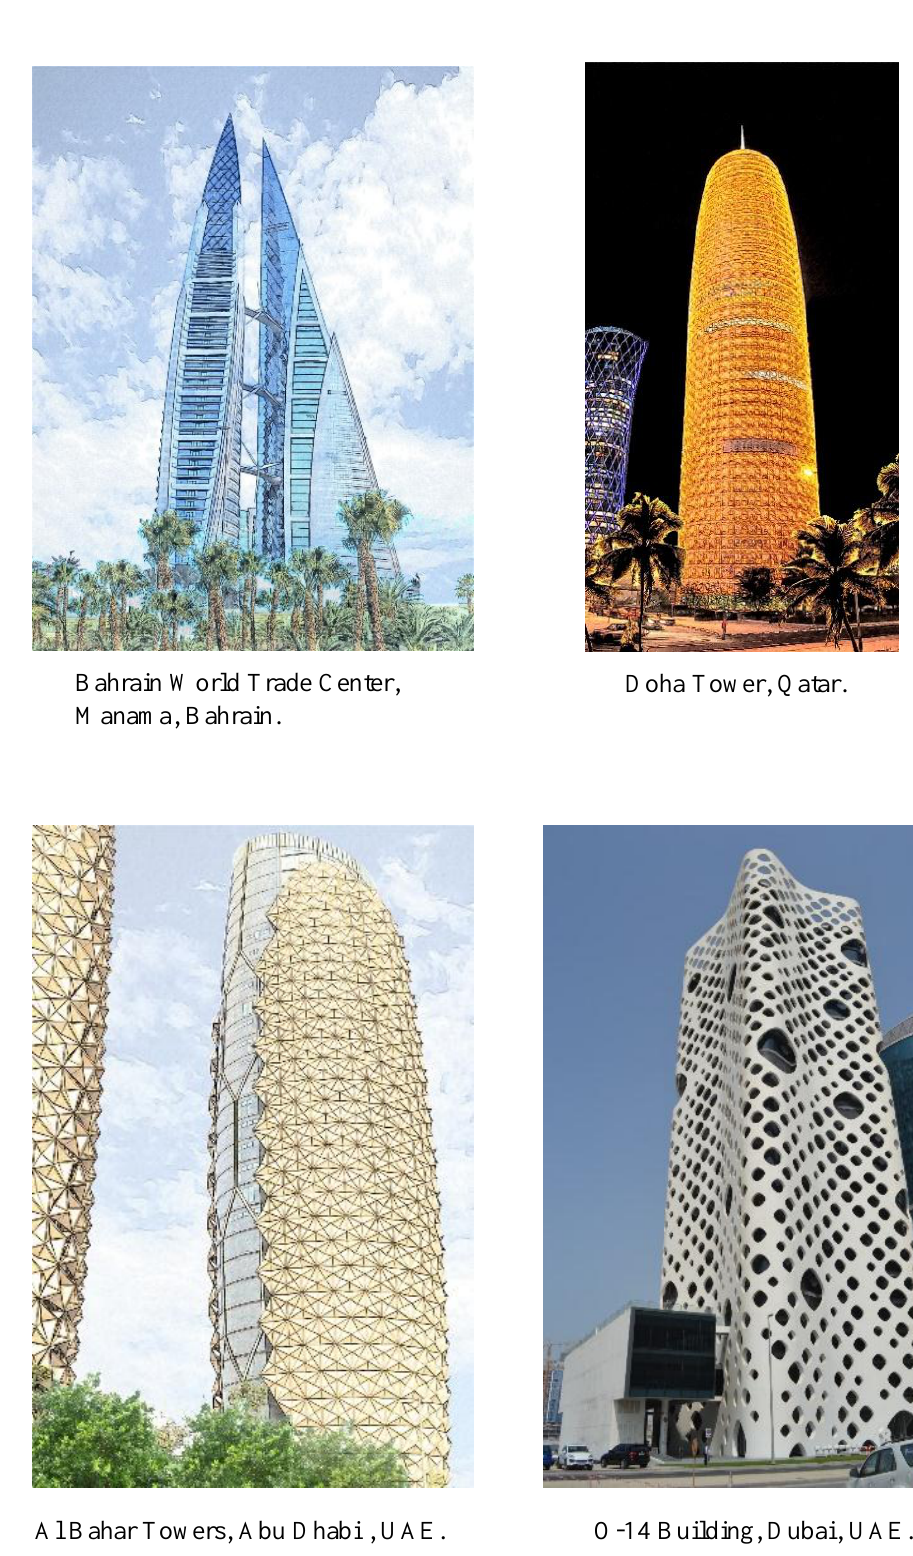
Figure 2. Figure 2. The Middle East